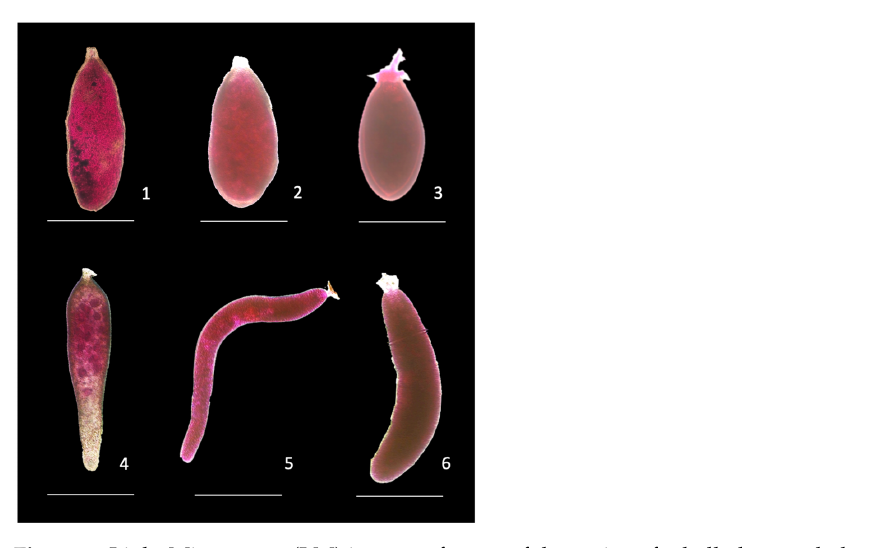
Figure 5. Light Microscopy (LM) images of some of the main soft-shelled monothalamous taxa RB stained. 1. Psammophaga cristallifera , 20× magnification; 2. Saccaminiid sp.1 (silver), 20× magnification; 3. Saccaminiid sp. 4 (white), 20 × magnification; 4. Conqueria leavis -like, 40 × magnification; 5. Cylindrogullmia -like, 10 × magnification; 6 Gloiogullmia -like, 10 × magnification. Scale bar 50 µ